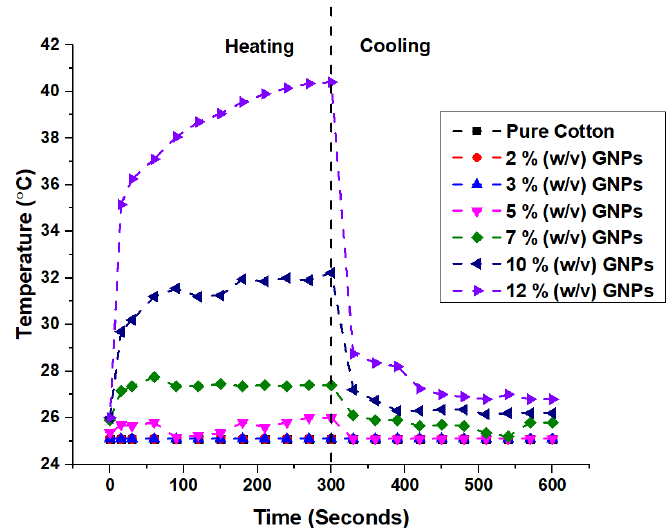
Figure 11. Heating of cotton fabrics coated with 1 Layer